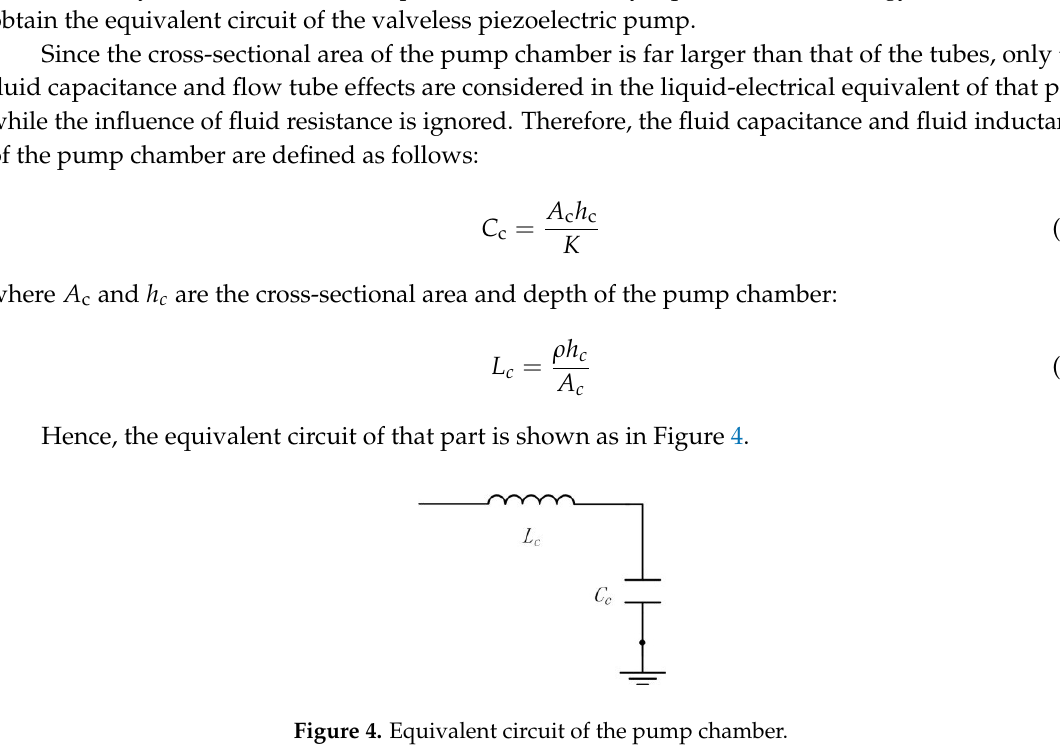
Figure 5. Equivalent circuit of tubes with fluid resistance differences.